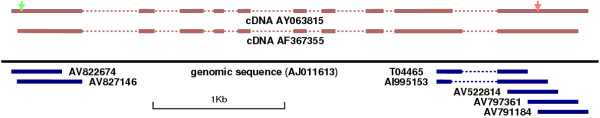
EST/cDNA alignments on the spl7 gene region. Thick lines represent matches an dotted lines, gaps. Above the genomic sequence, the 2 full-length cDNAs that provide the two correct reference gene structures are presented. Arrows indicate the start and stop codons. The ESTs T04465 and AI995153 present inconsistent splicing profiles and are labeled as incompatible.